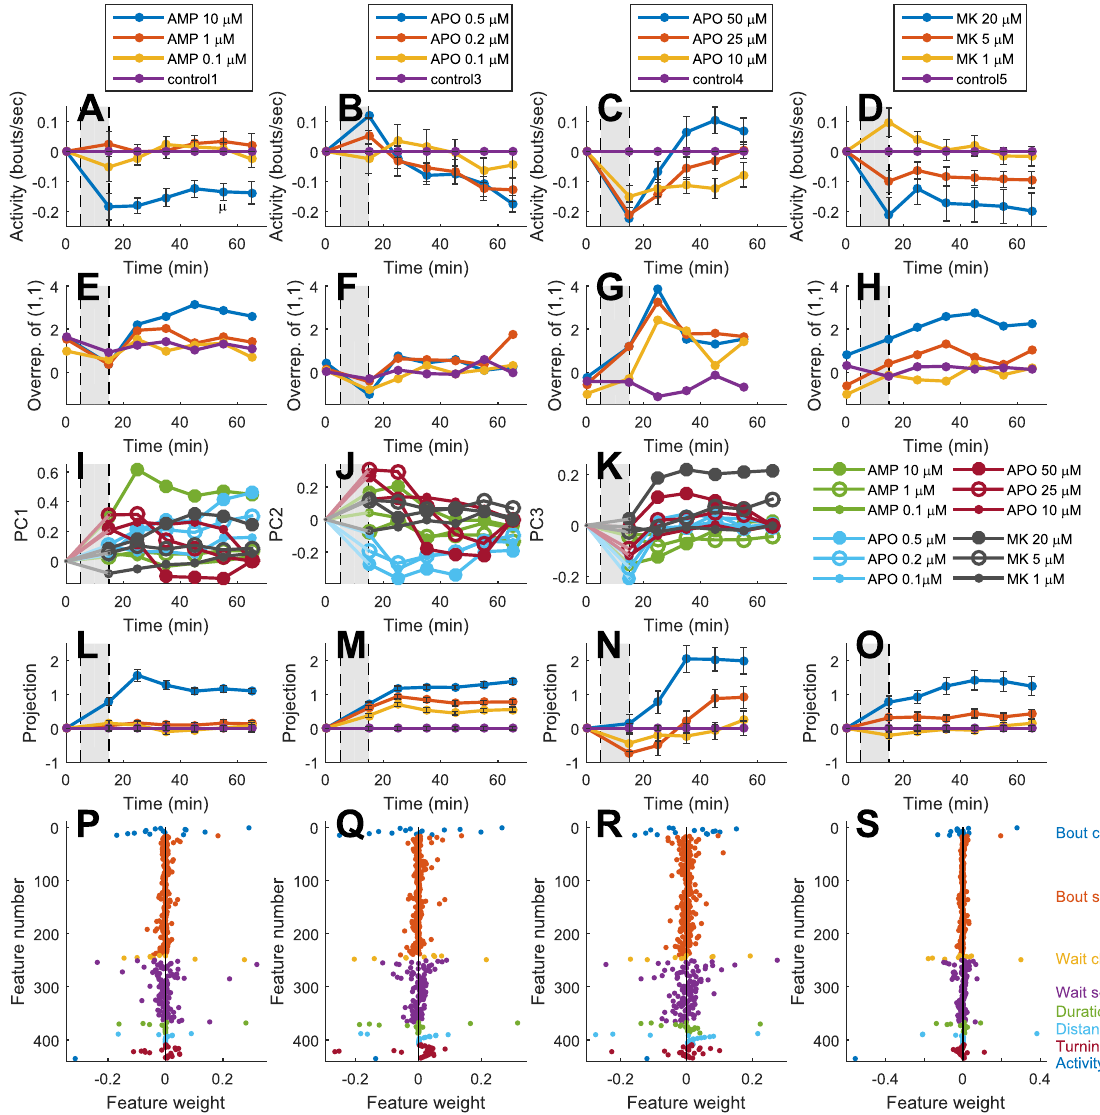
Figure 5. Pharmacological manipulations induce specific changes in swimming behavior involving both simple kinematic features and action sequencing. ( A–D ) Example of pharmacological effects on a single kinematic feature: Changes in the average number of bouts displayed per second following different pharmacological manipulations (shaded area) throughout the recording period reveal drug and dose specific effects. ( E–H ) Example of pharmacological effects on higher order organization of behavior: Changes in the relative overrepresentation of one specific bout pair (type1-type 1, cf. Fig. 2) reveal drug and dose specific effects. Values presented represent the probability (in %) of observing the pair [1, 1] minus the theoretical probability based on the overall observed frequency of the constituent bout type during the same period of time period. ( I–K ) Global changes in swimming behavior shown for each of the treatment groups for the first three dimensions in a PCA sub-space constructed from the larger 435-dimensional feature space. Note the relative separation of the different drug treated groups in certain dimensions and the relative smoothness of the curves indicating gradual rather than abrupt changes in the global motor behavior of each treatment group over time. ( L–O ) Dose dependence of the behavioral changes induced by each drug. The average behavior displayed by the group receiving the highest dose minus the behavior of the control group represents the specific direction and size ( = 1) of the vector in feature space for each drug. Geometrical projection of the feature vectors obtained for the different doses/time points are plotted for each set of experiments. Note that lower doses generally show intermediate behavioral changes and that all treatment groups show robust effects over time (x-axis represent consecutive non-overlapping sample points from 0 to 65 min). ( P–S ) The relative contribution of the different kinematic features to the global representation of the behavioral changes characterizing each drug. Deviations from zero indicate a difference in this kinematic feature between each drug-treated group and the corresponding control group (e.g. the blue dot with feature #435 marks the reduced activity shown in 5 A–D ). Notably several of the features show clear drug-induced changes. Whiskers denote SEM. [Drug abbreviations: AMP = amphetamine; APO = apomorphine; MK =